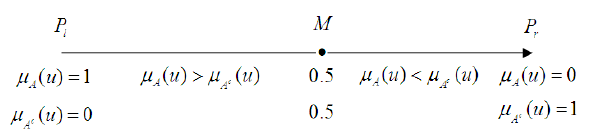
Fig. 2. Relationship between point M , and internals [ p,q ] , [ m,n ]